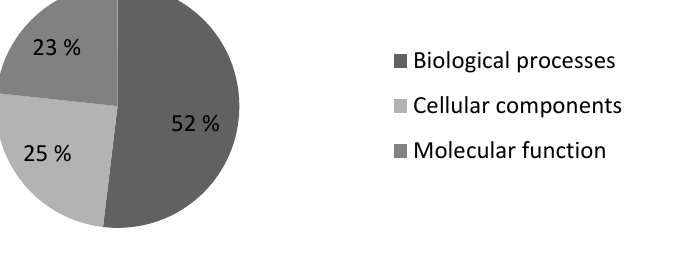
Fig. 2. Gene Ontology categories. The figure represents the pie chart distribution of three GO categories, namely, biological processes, cellular components and molecular function. All 14875 genes expressed in the data were used for the ontology